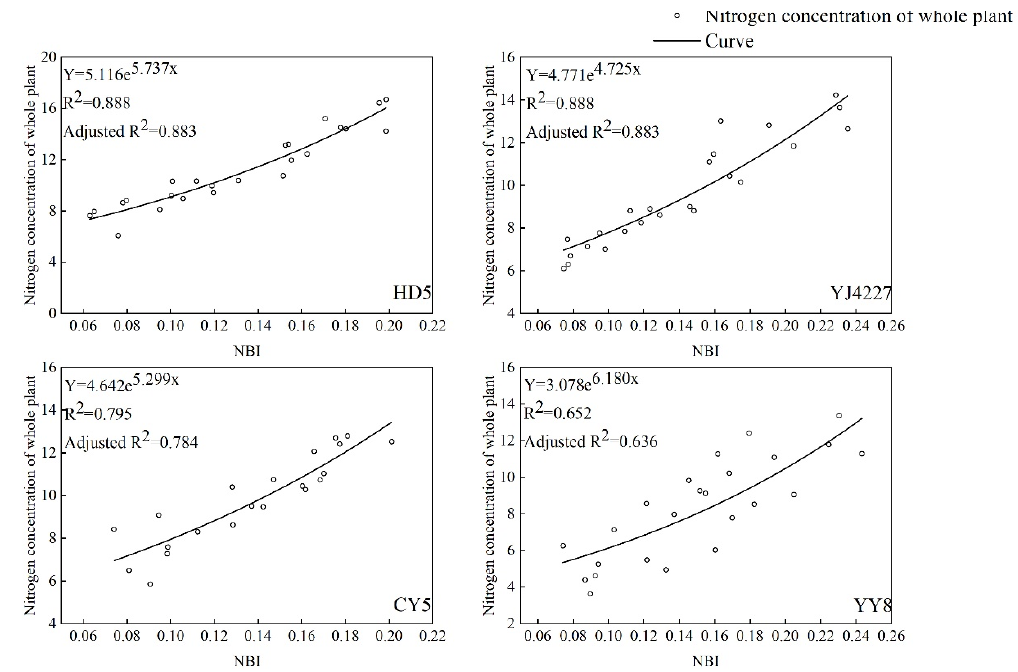
Figure 12. Curves for the whole ‐ plant nitrogen content vs. the NBI of rice leaves after anthesis.